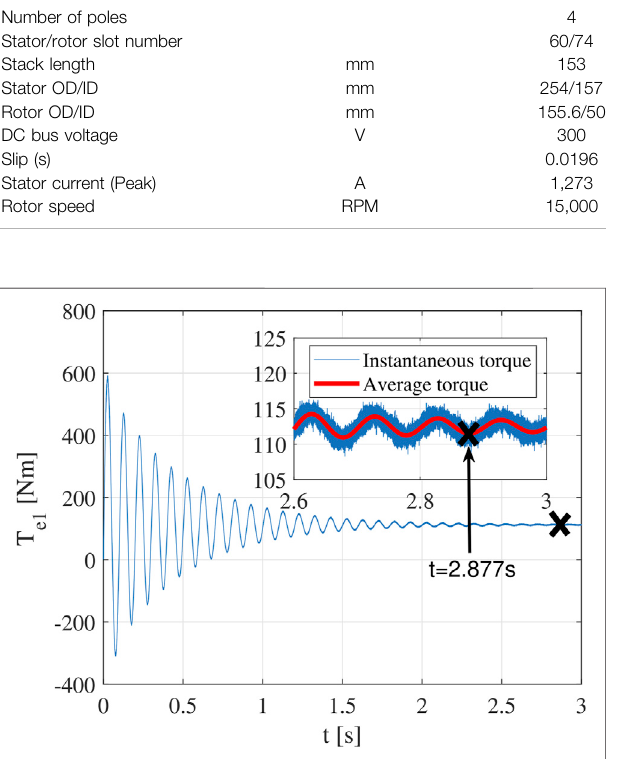
FIGURE 7 | Torque of the constant I s method (FEA result).